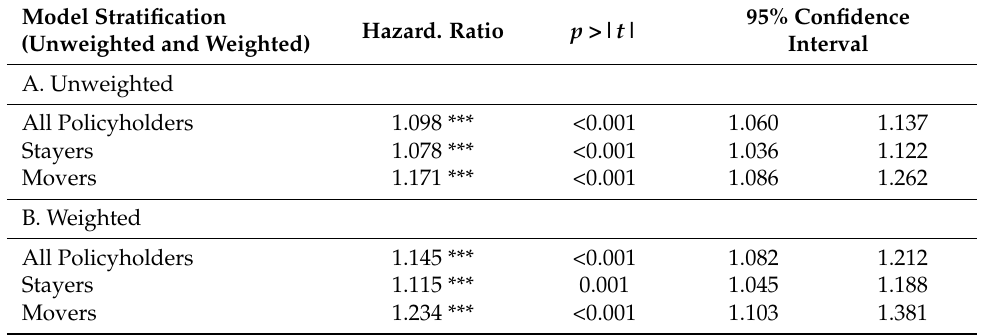
Table 7. Estimated hazard of dying for neighborhood disadvantage for all policyholders, policyholders who stayed in their zip code, policyholders who moved to another zip